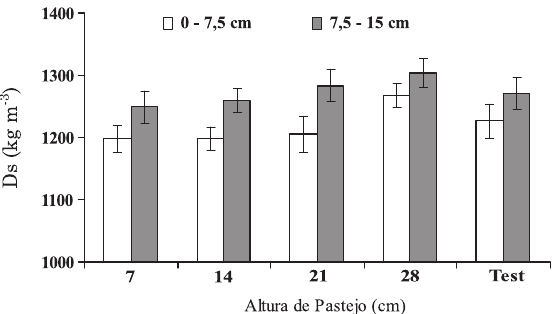
Figura 2. densidade do solo (ds) nas camadas de 0–7,5 e 7,5–15 cm para as alturas de pastejo de 7, 14, 21 e 28 cm e testemunha (test). As barras referem-se ao intervalo de confiança da média, e a sobreposição dos intervalos de confiança indica ausência de diferenças entre as médias dos tratamentos.